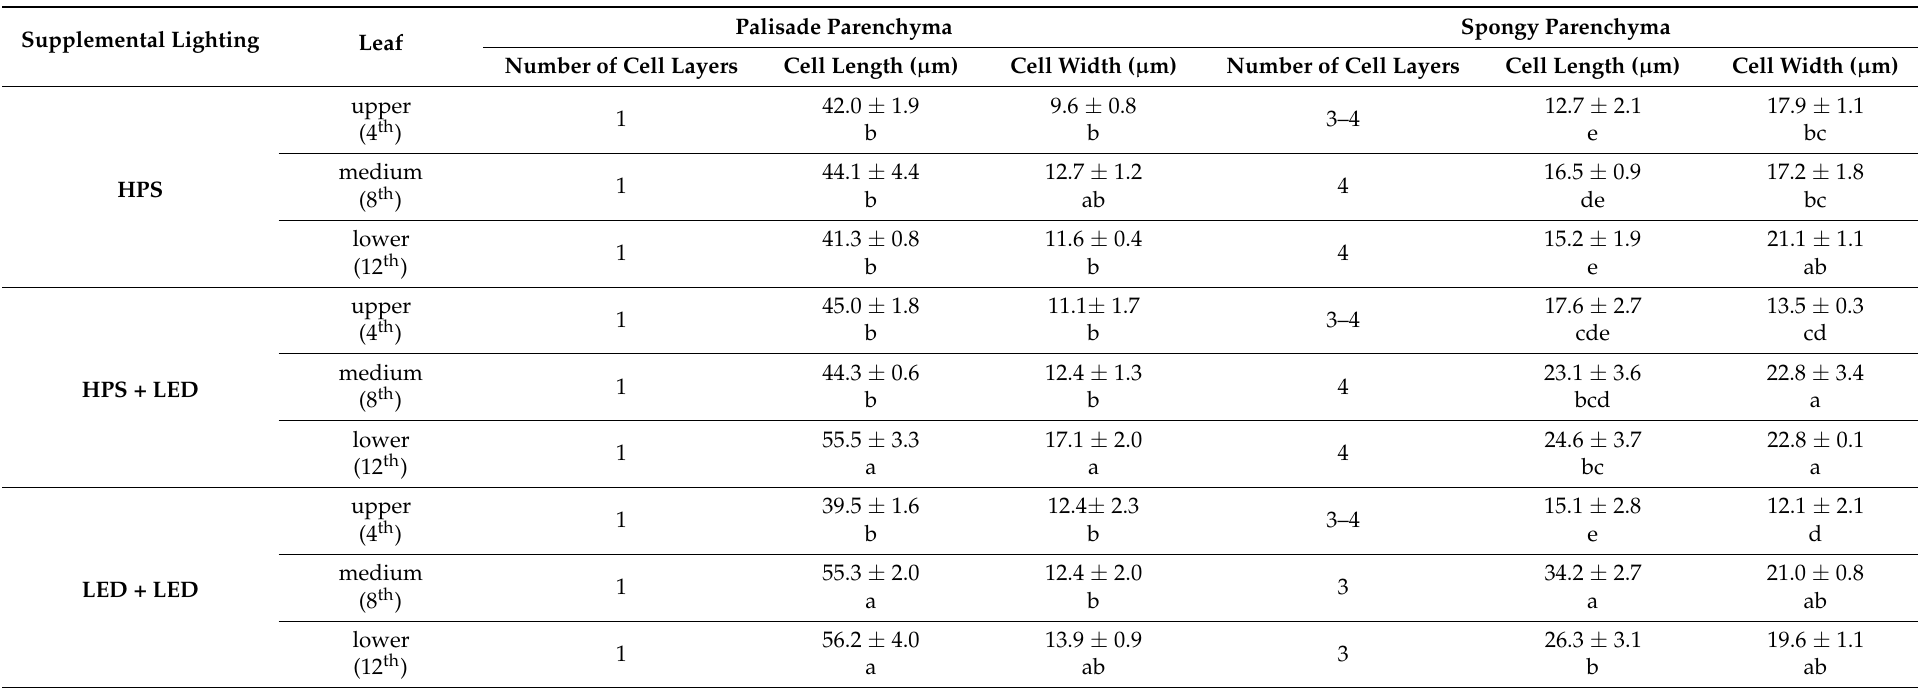
Table 1. Analysed leaf traits depending on the supplemental